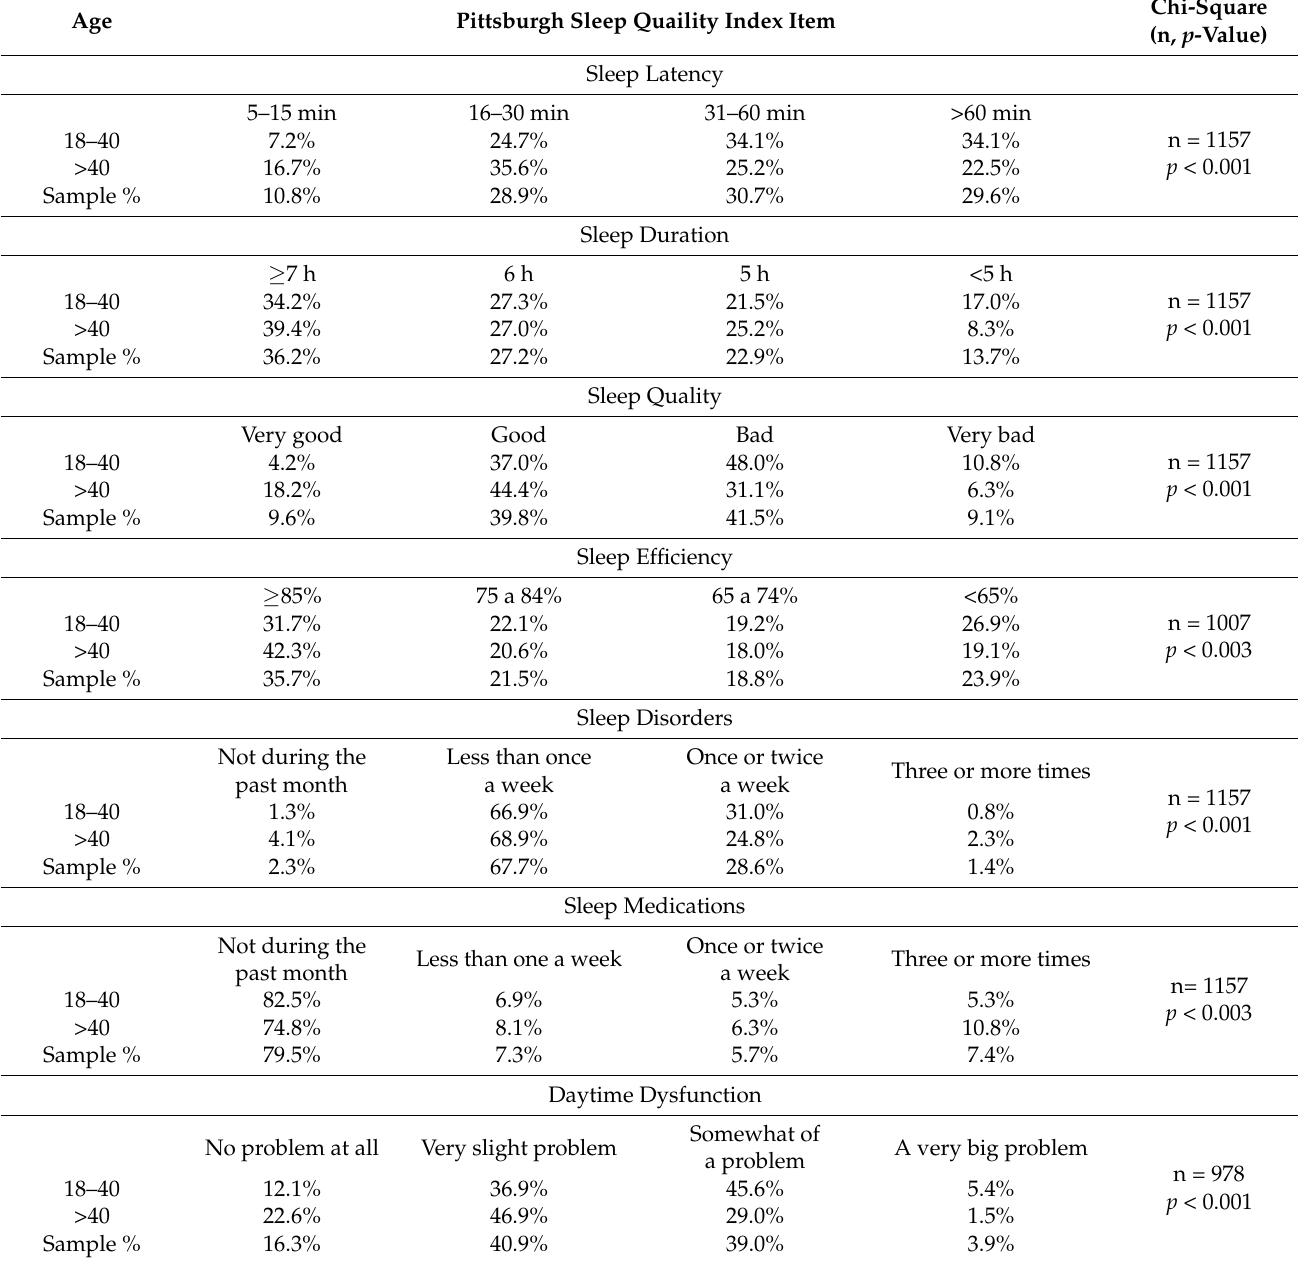
Table 2. Differences for the Pittsburgh Sleep Quality Index items according to age grouping when the chi-square test was